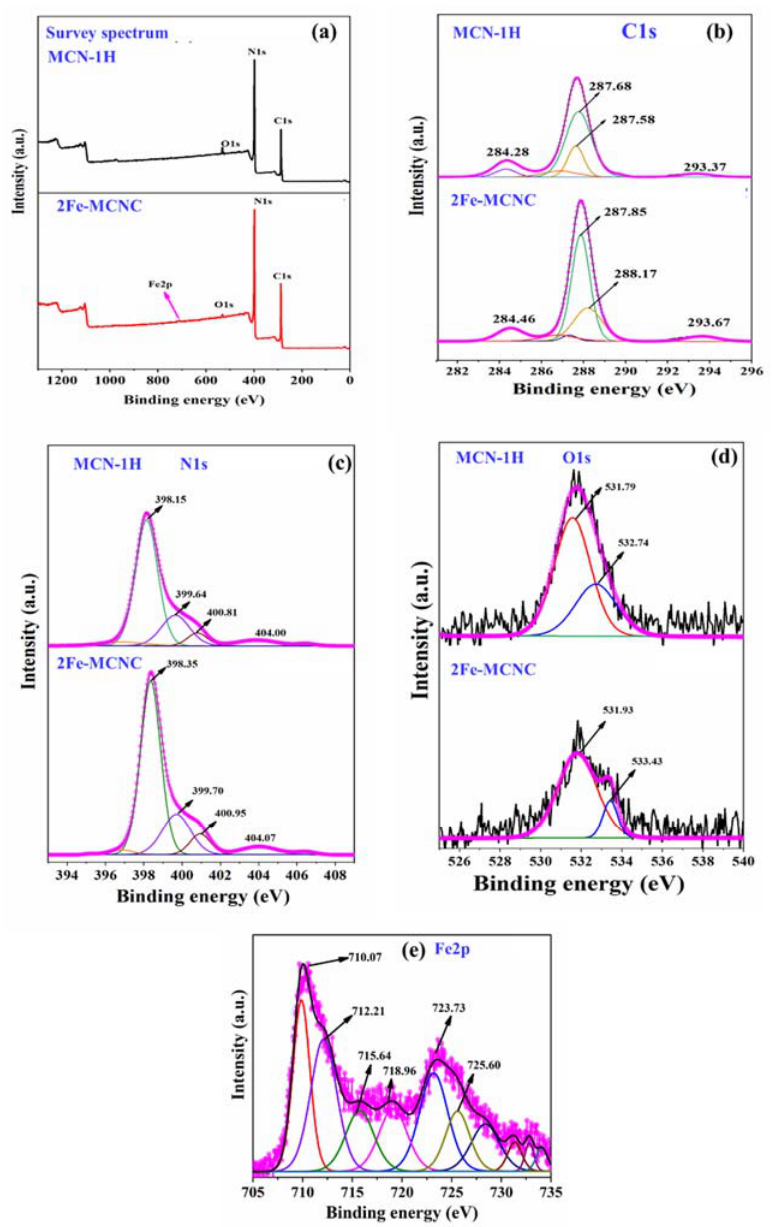
Figure 5. Comparative XPS spectra of MCN-1H and 2Fe-MCNC ( a ) survey spectrum, high-resolution XPS spectra ( b ) C1s, ( c ) N1s ( d ) O1s, and ( e ) Fe2p.